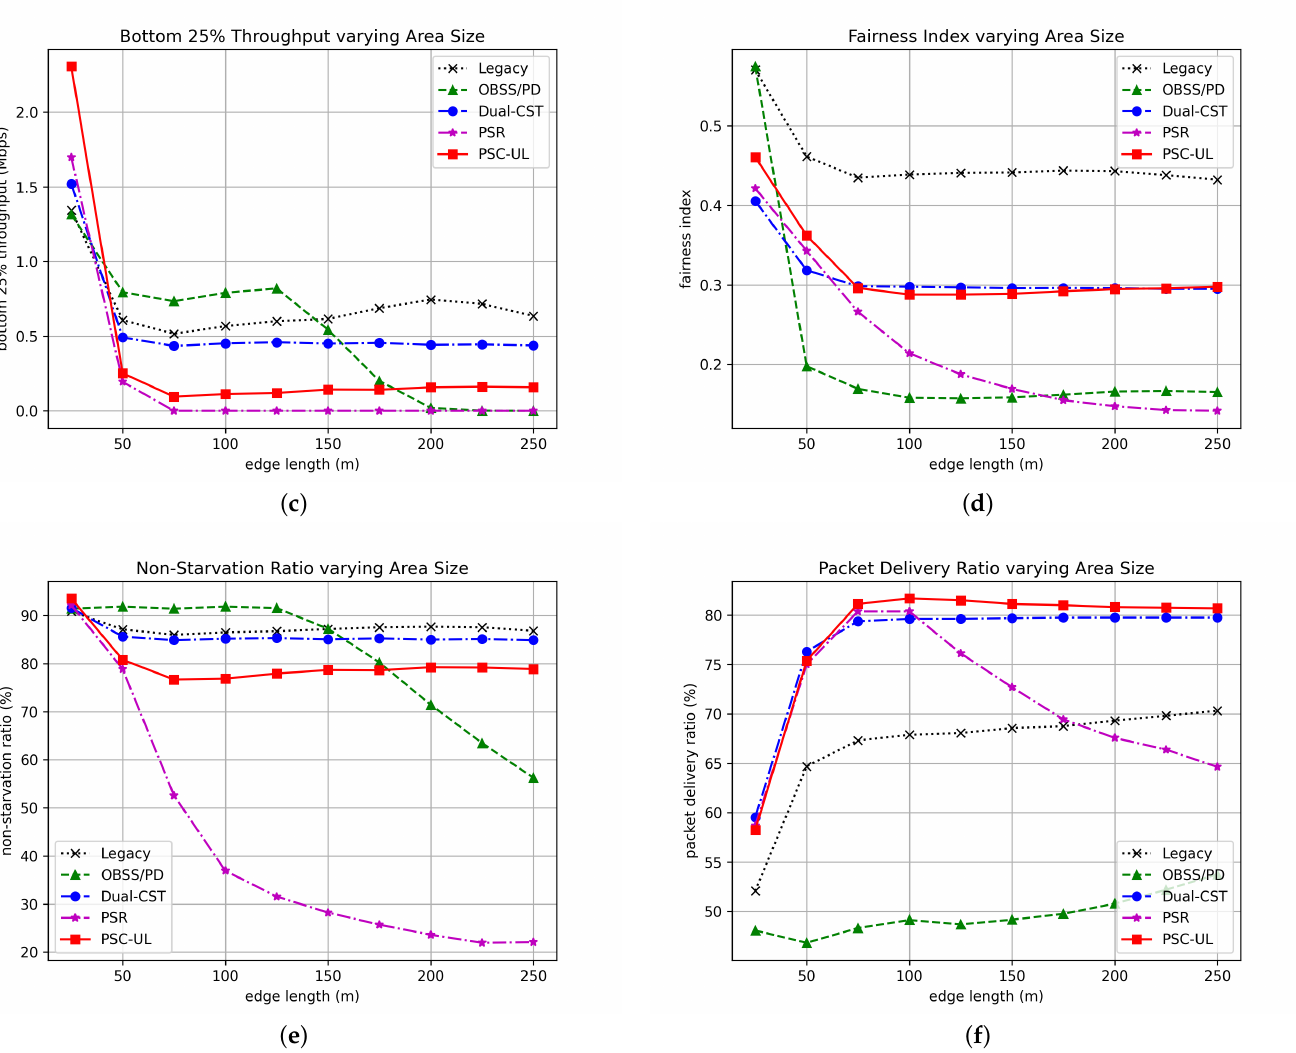
Figure 11. Performance of methods varying area size. ( a ) Total throughput; ( b ) Bottom 50% throughput; ( c ) Bottom 25% throughput; ( d ) Fairness; ( e ) Non-starvation Ratio; ( f ) Delivery